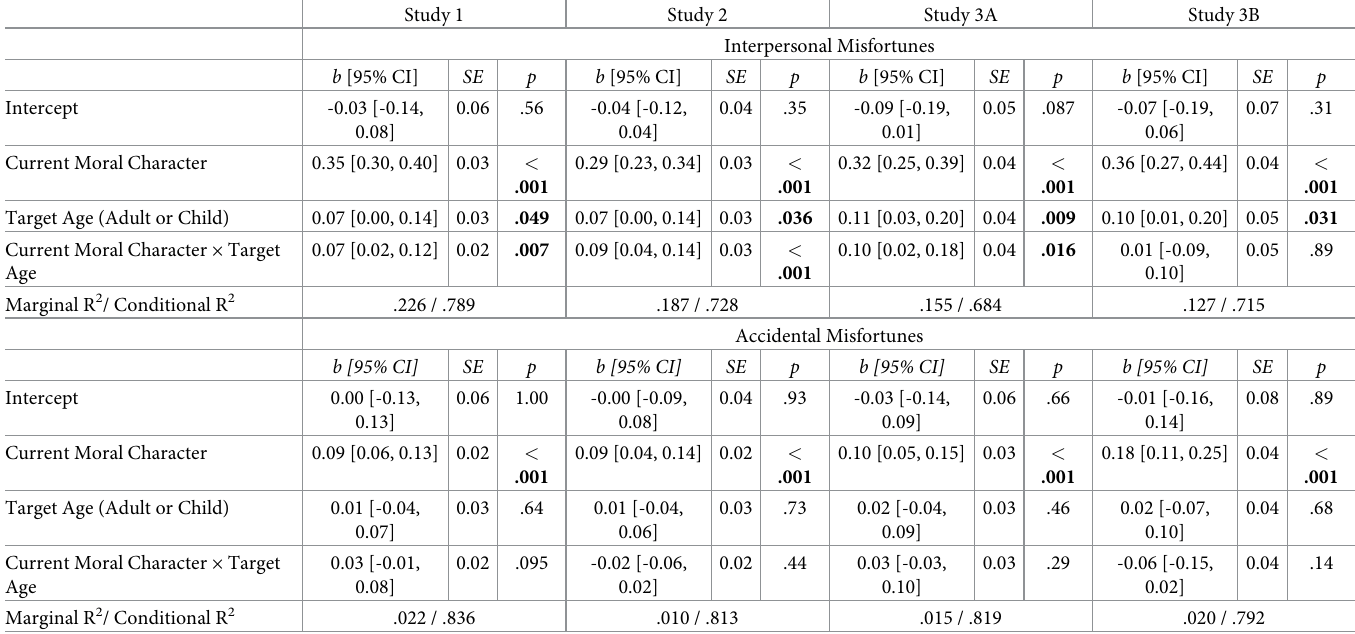
Table 3. Forecasts about future misfortunes (interpersonal and accidental) predicted by (a) inferences about current moral character, (b) target age (adult or child), and (c) the interaction between current moral character and target